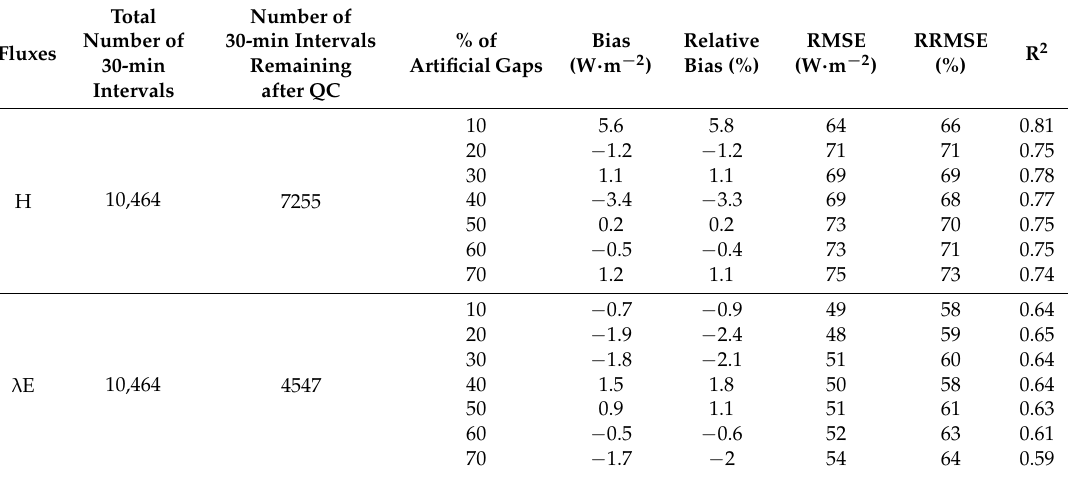
Table 2. Statistical indicators for the cross-validation of REddyProc. The total number of 30-min intervals correspond to the duration of the considered period (9 February 2011 to 15 September 2011). The percentage of artificial gaps was applied to the number of 30-min intervals remaining after QC. Accuracy is quantified using statistical indicators (absolute and relative bias, absolute and relative RMSE, coefficient of determination R 2